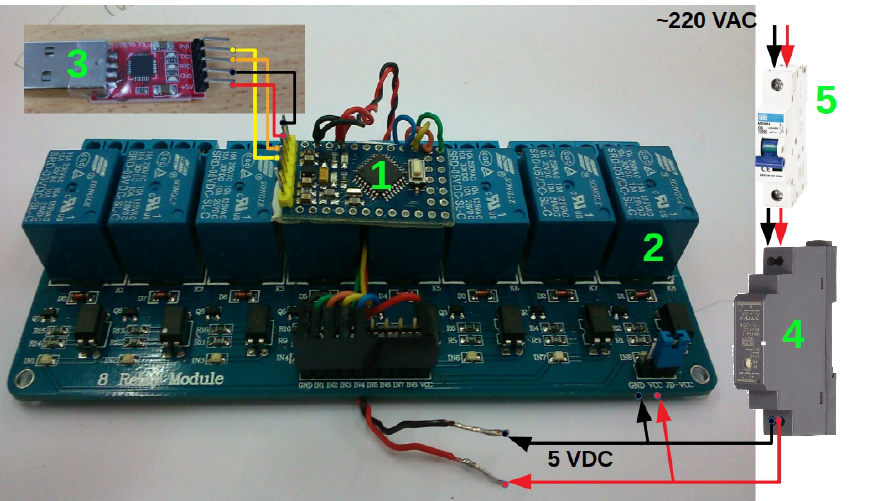
Figure 4. Arduino Pro Mini (1) attached to the 8-Channel Relay Module (2) and the USB-TTL converter (3) for connection to the computer. The power supply (4) delivers current to both the Arduino and the relay module. A circuit breaker (5) is also added, in order to protect the above electrical components from an overload or